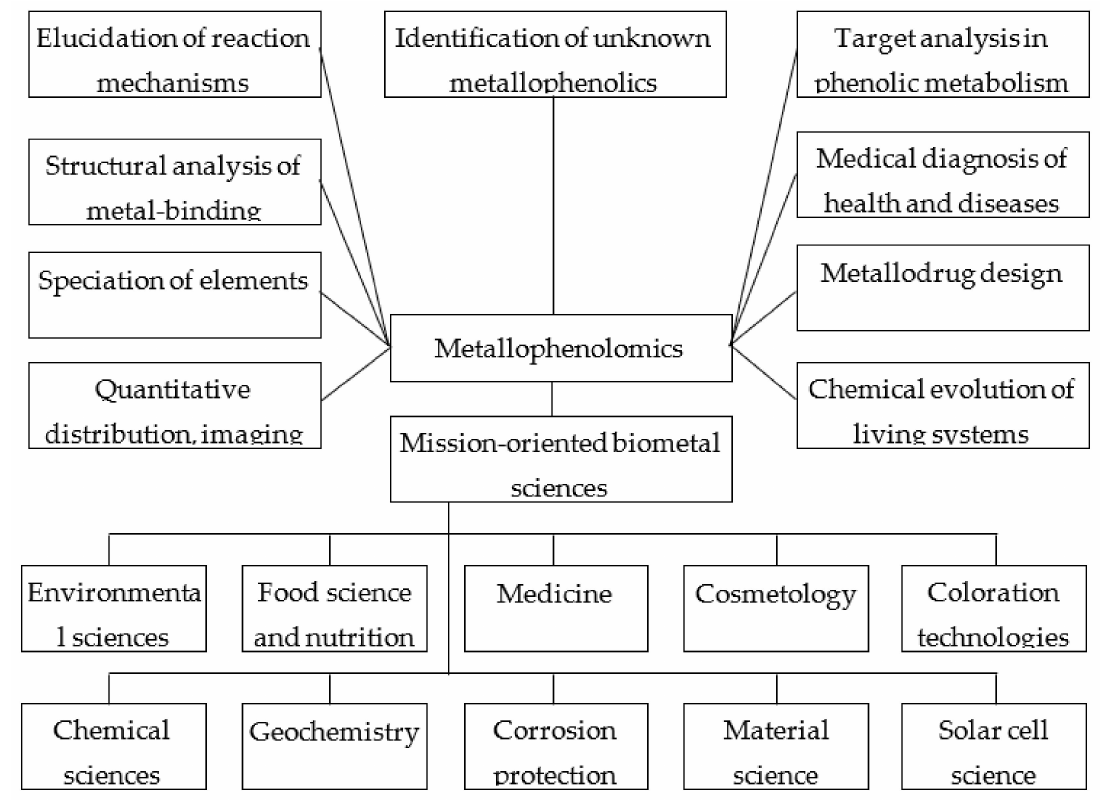
Figure 4. Research subjects of